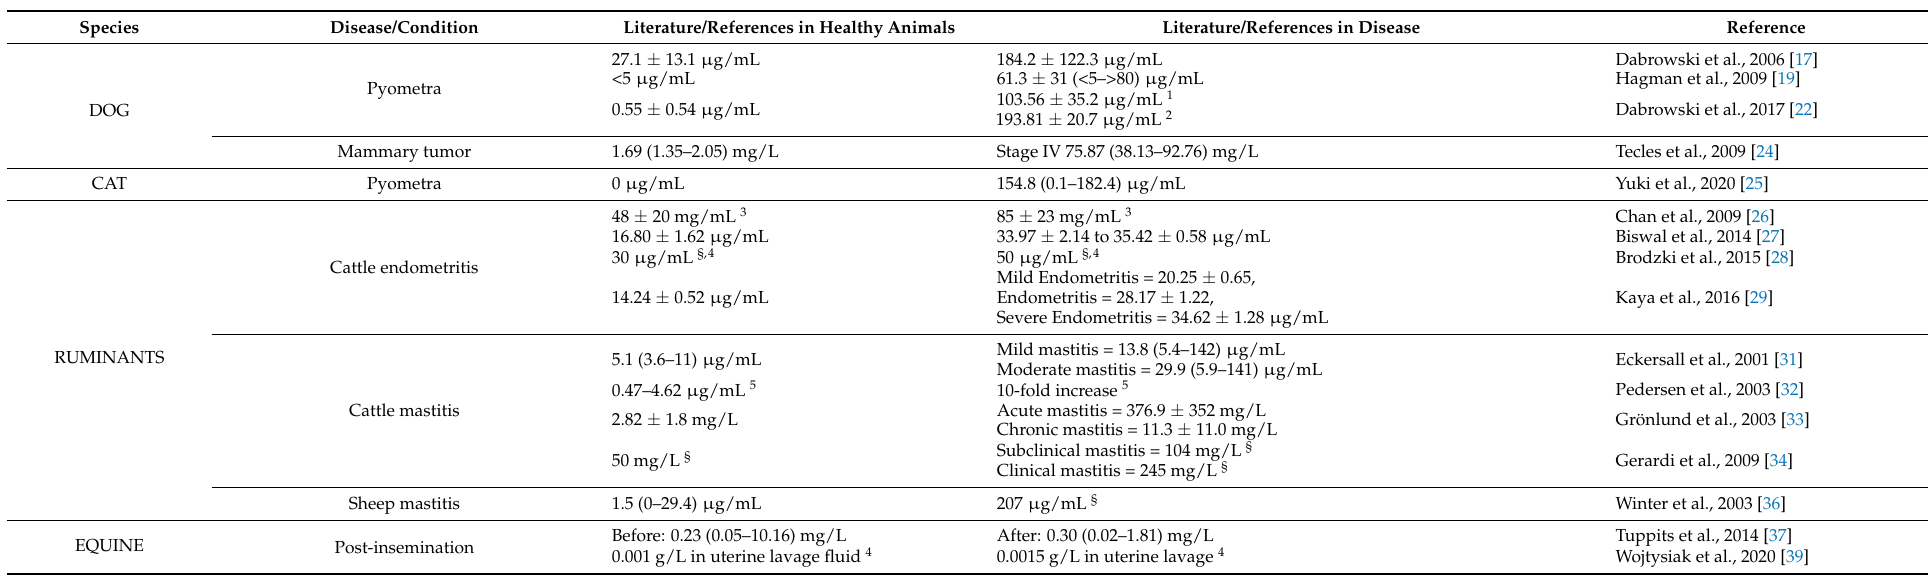
Table 2. Comparison of concentration of serum amyloid A on serum samples in healthy and disease, considering the literature currently